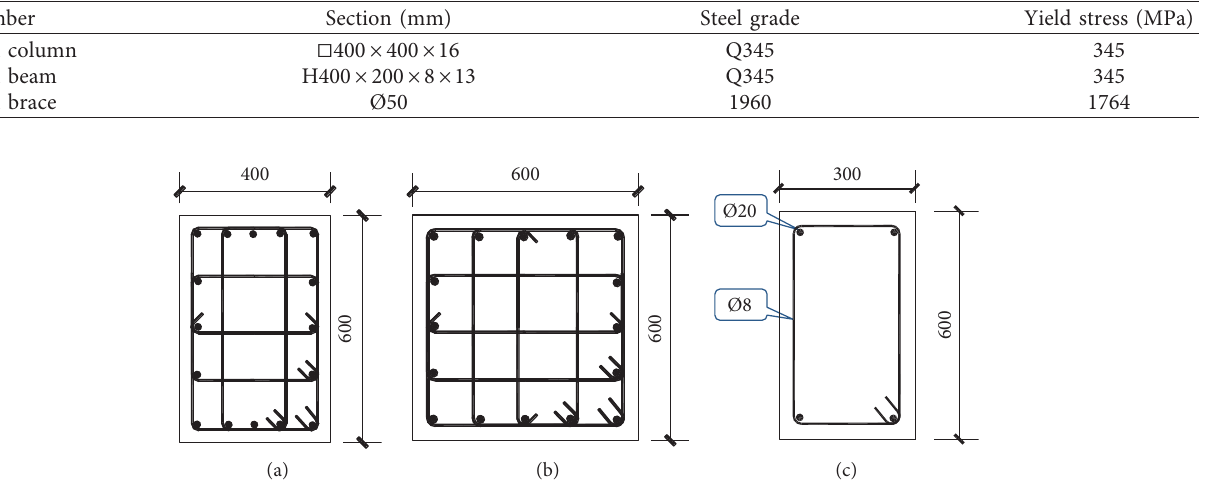
Figure 11: RC member sections and reinforcement configurations. (a) RC column, (b) RC corner column, and (c) RC beam. Table 2: Reinforcements of RC column and RC corner column.